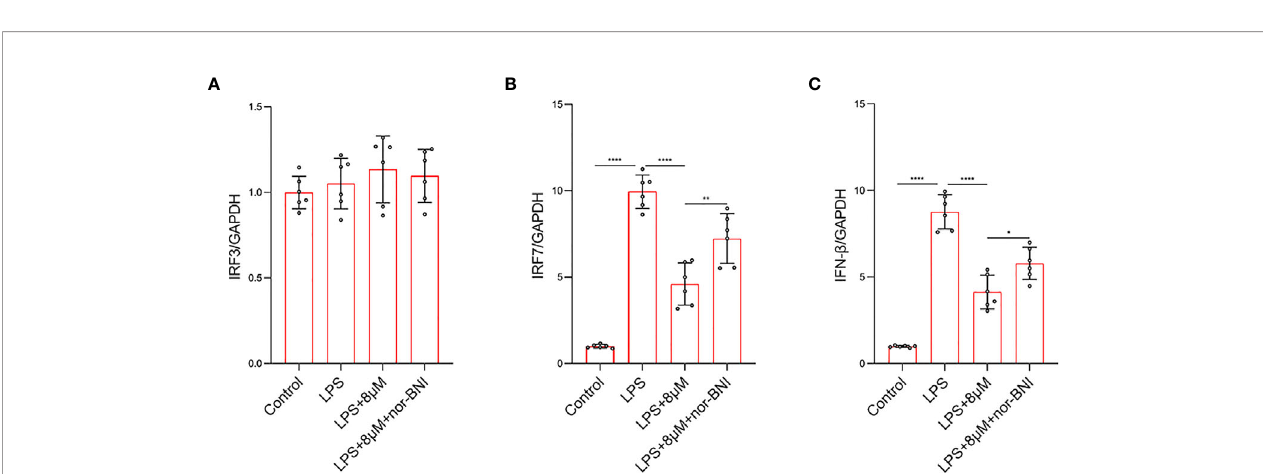
FIGURE 10 | Butorphanol decreased LPS-induced the elevation of IRF7 and IFN- b through KOR in M1-polarized BMDMs. Macrophages were collected and cultured from the bone marrow of mice and incubated with LPS (1 m g·mL -1 ) alone, butorphanol (8 m M) plus LPS (1 m g·mL -1 ) or nor-BNI (KOR antagonist, 5 m M) plus butorphanol (8 m M) plus LPS (1 m g·mL -1 ) for 6 h. Cells were pretreated with nor-BNI for 30 min. (A – C) The mRNA levels of IRF3, IRF7, and IFN- b in cells were measured by qRT-PCR. The results are the means ± SEM of six independent experiments. Statistical analysis was performed by one-way ANOVA followed